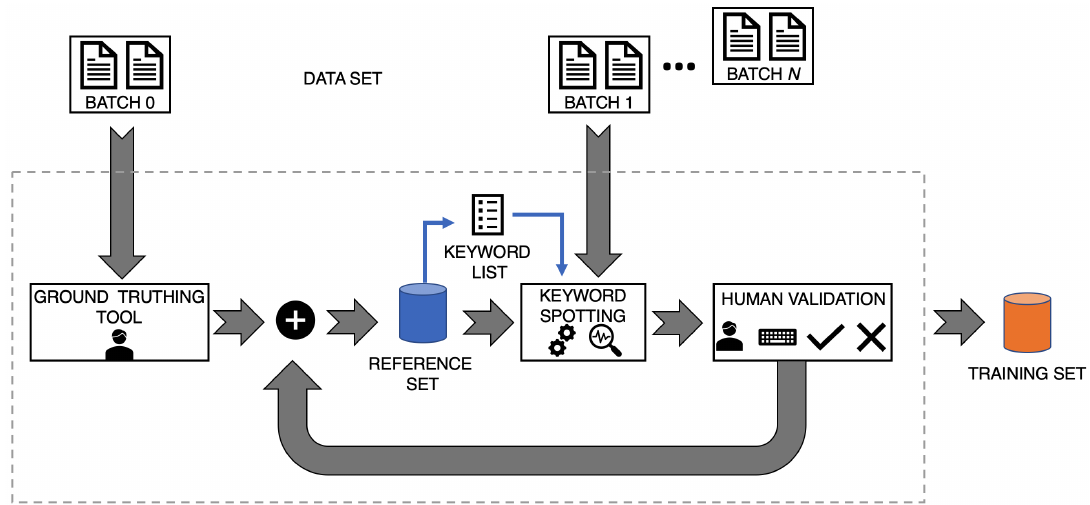
Figure 2. Architecture of a system for building up a training set through a multi-step procedure that interleaves a query-by-string retrieval system and human validation. The data set is divided in batches. Batch 0 is manually transcribed, while the other ones are processed by the keyword spotting (KWS) system and the human validation stage. The keyword list contains the transcriptions of word images included in the reference set with no repetitions. The keyword list is used for querying the KWS system and spotting word images in the batch under analysis. At each step the reference set is updated with the word images of the batch in which the transcription is not yet contained in the keyword list. Thus, at the end of the multi-step procedure, the data set is transcribed and the training set is created.